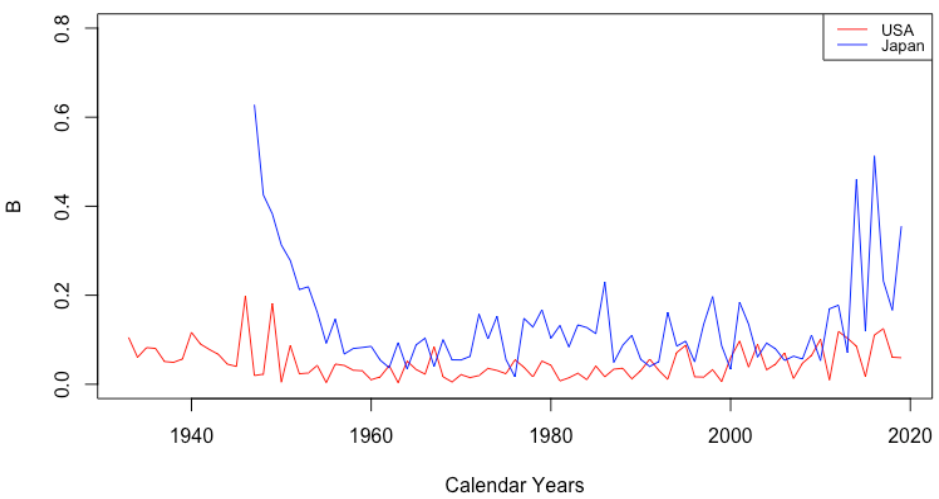
Figure 5. Comparison of B between Japan and the USA.